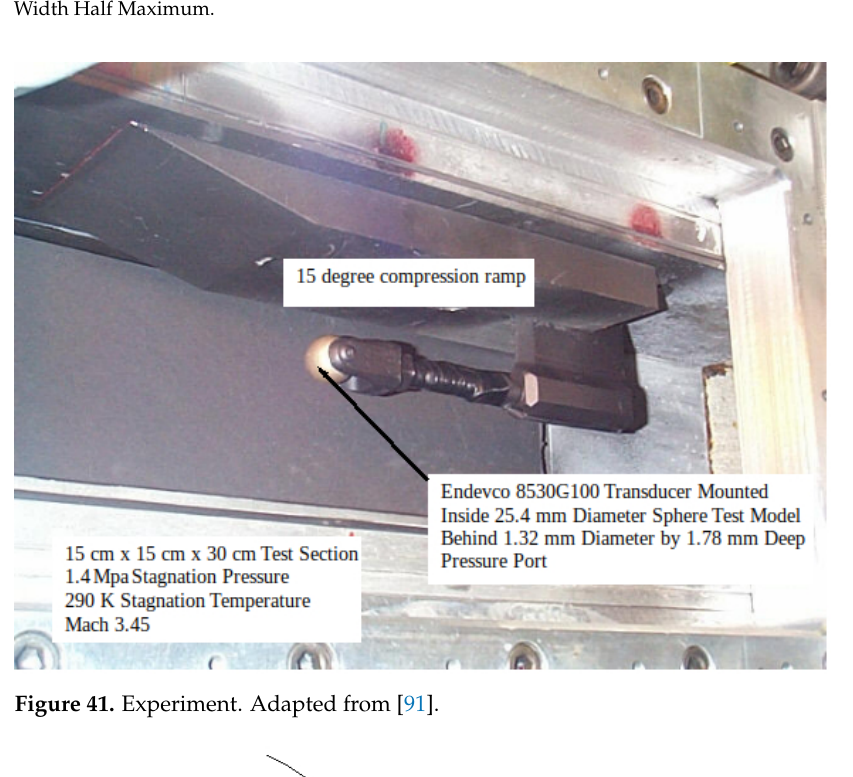
Figure 41. Experiment. Adapted from [91].